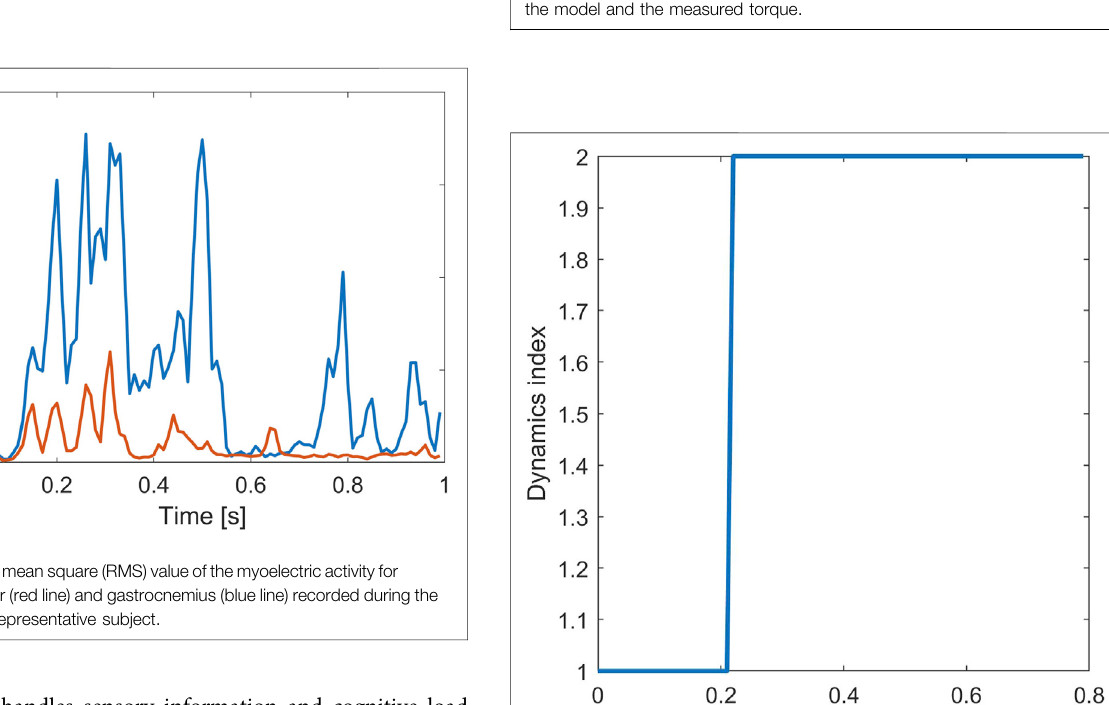
FIGURE 6 | Error signal autocorrelation for a representative subject. The error signal was obtained as the difference between the output generated by the model and the measured torque.